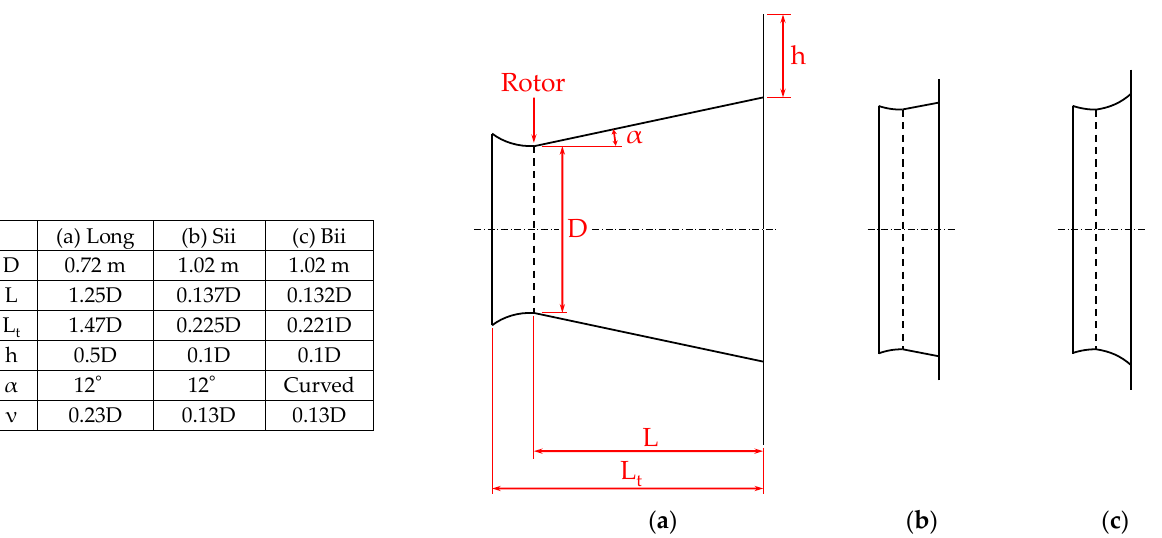
Figure 9. Configuration of the WLT models used in the experiment: ( a ) long type corresponds to the brimmed diffuser shown in Figure 2; ( b ) Sii refers to a straight diffuser with a brim and an open angle of 12 degrees; ( c ) Bii corresponds to the compact brimmed diffuser shown in Figure 3.